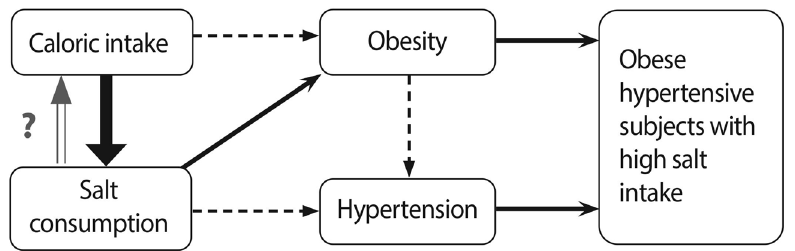
Figure 7. Proposed model of the relationship between caloric intake, salt consumption, hypertension and obesity based on the present survey and existing concepts. Key findings from this study are marked by a bold arrow and confirmatory findings by regular arrows. These are integrated into established connections (dashed arrows). Overall caloric intake promotes not only obesity, but also salt intake which is independently